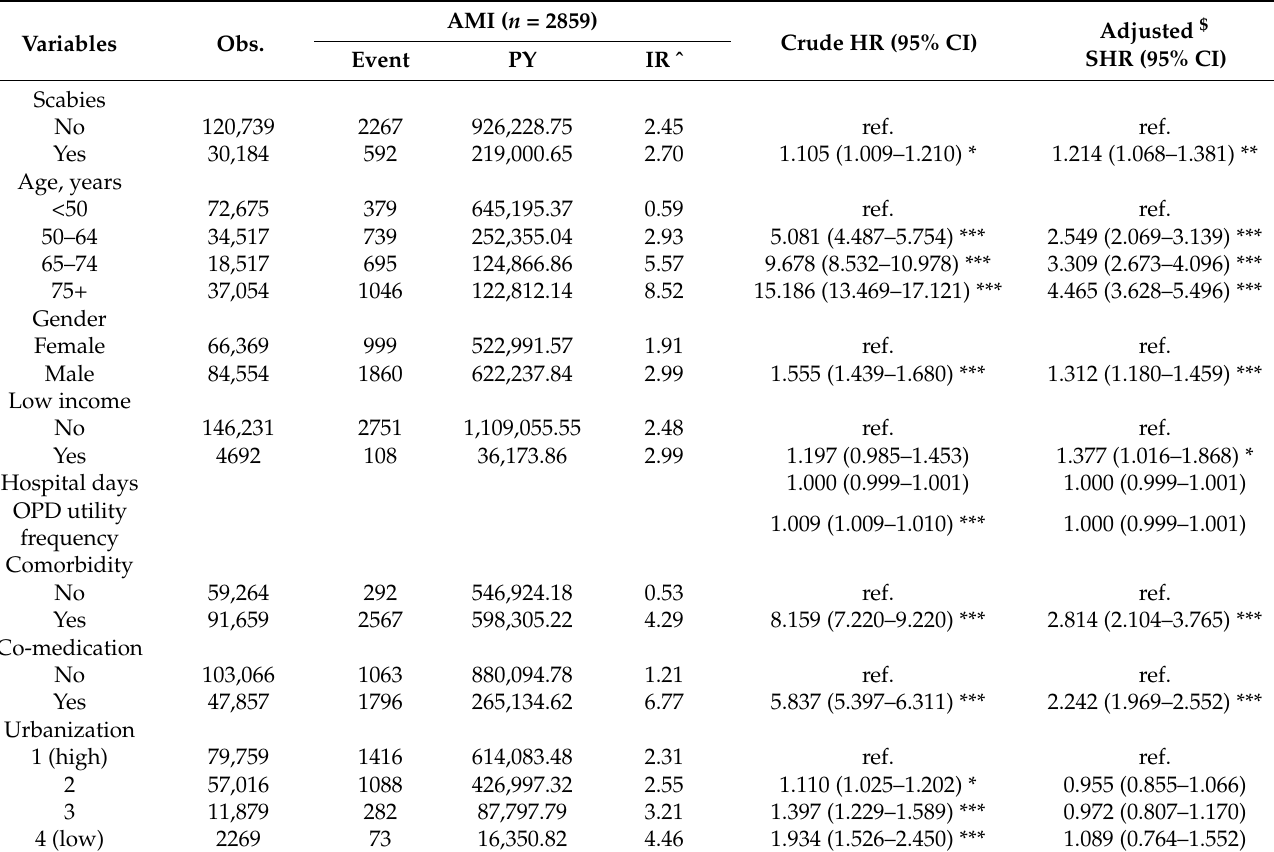
Table 2. HRs and 95% CIs of AMI associated with scabies and other covariates (competing risk model of